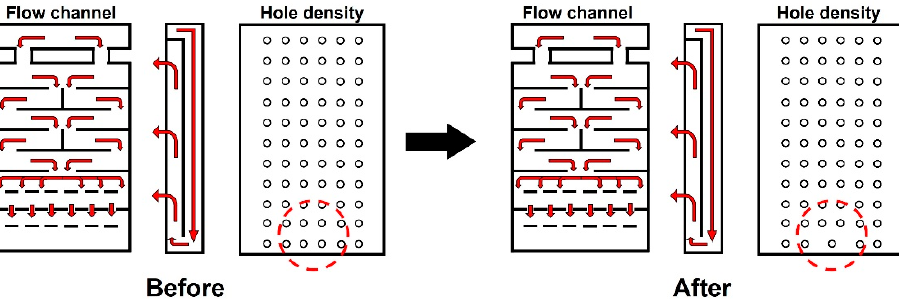
Figure 12. Adjustments in hole density to achieve a uniform temperature distribution.